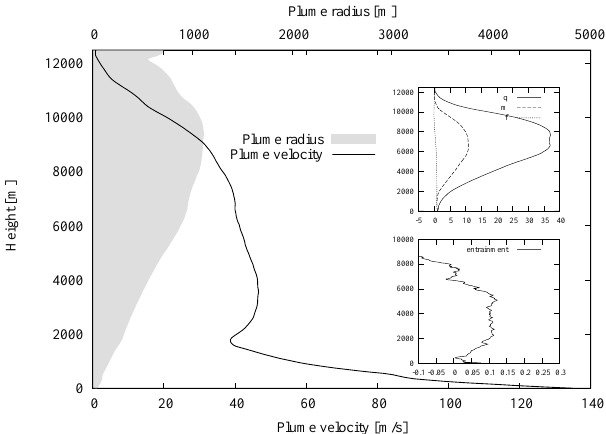
Figure 20. Time-averaged plume radius and velocity. The insets display the non-dimensional mass, momentum and buoyancy fluxes (top) and the time-averaged entrainment coefficient κ . The results refer to the simulation at maximum resolution δ = 2 b 0 /